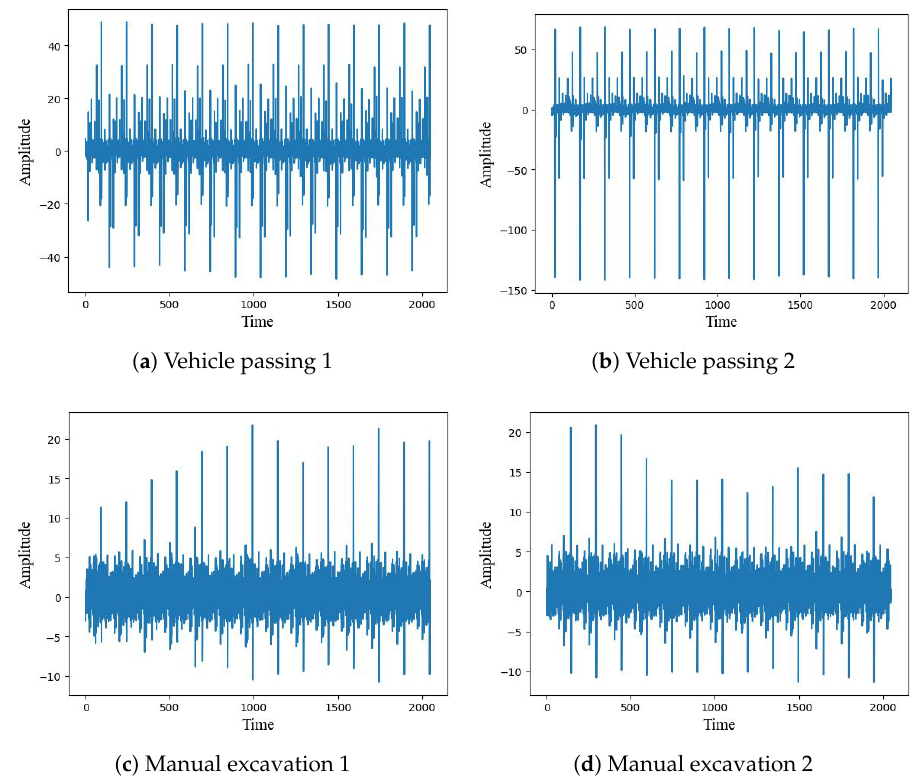
Figure 2. Comparison chart of different data segments. ( a , b ) are the data collected at the same location with different soil moisture conditions; ( c , d ) are the data collected at the same time with different